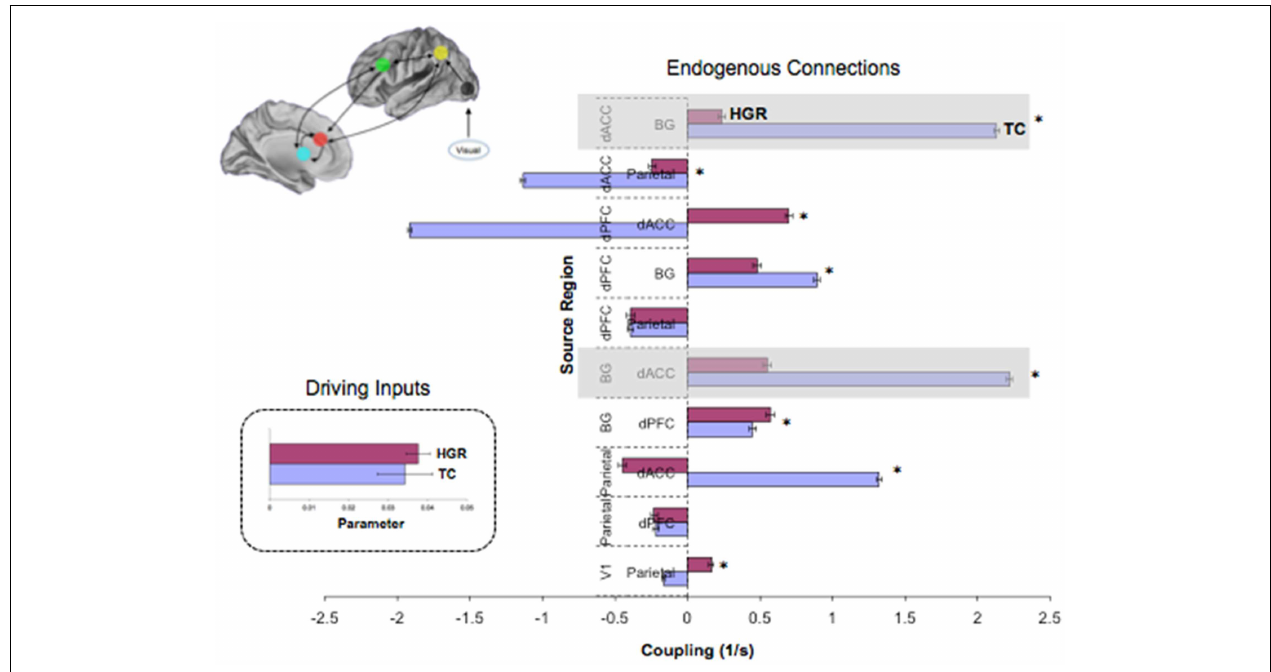
hypo-connectivity in the bilateral dACC–BG sub-circuit in HGR subjects. The negative/inhibitory dPFC coupling inTC may reflect competitive inhibition between frontal regions most associated with cognitive control, and is absent in HGR.The inset depicts driving inputs to the primary visual cortex (not different betweenTC and HGR). Despite model evidence suggestive of identical model structures, these data suggest that HGR are characterized by disordered effective connectivity in the modeled sustained attention